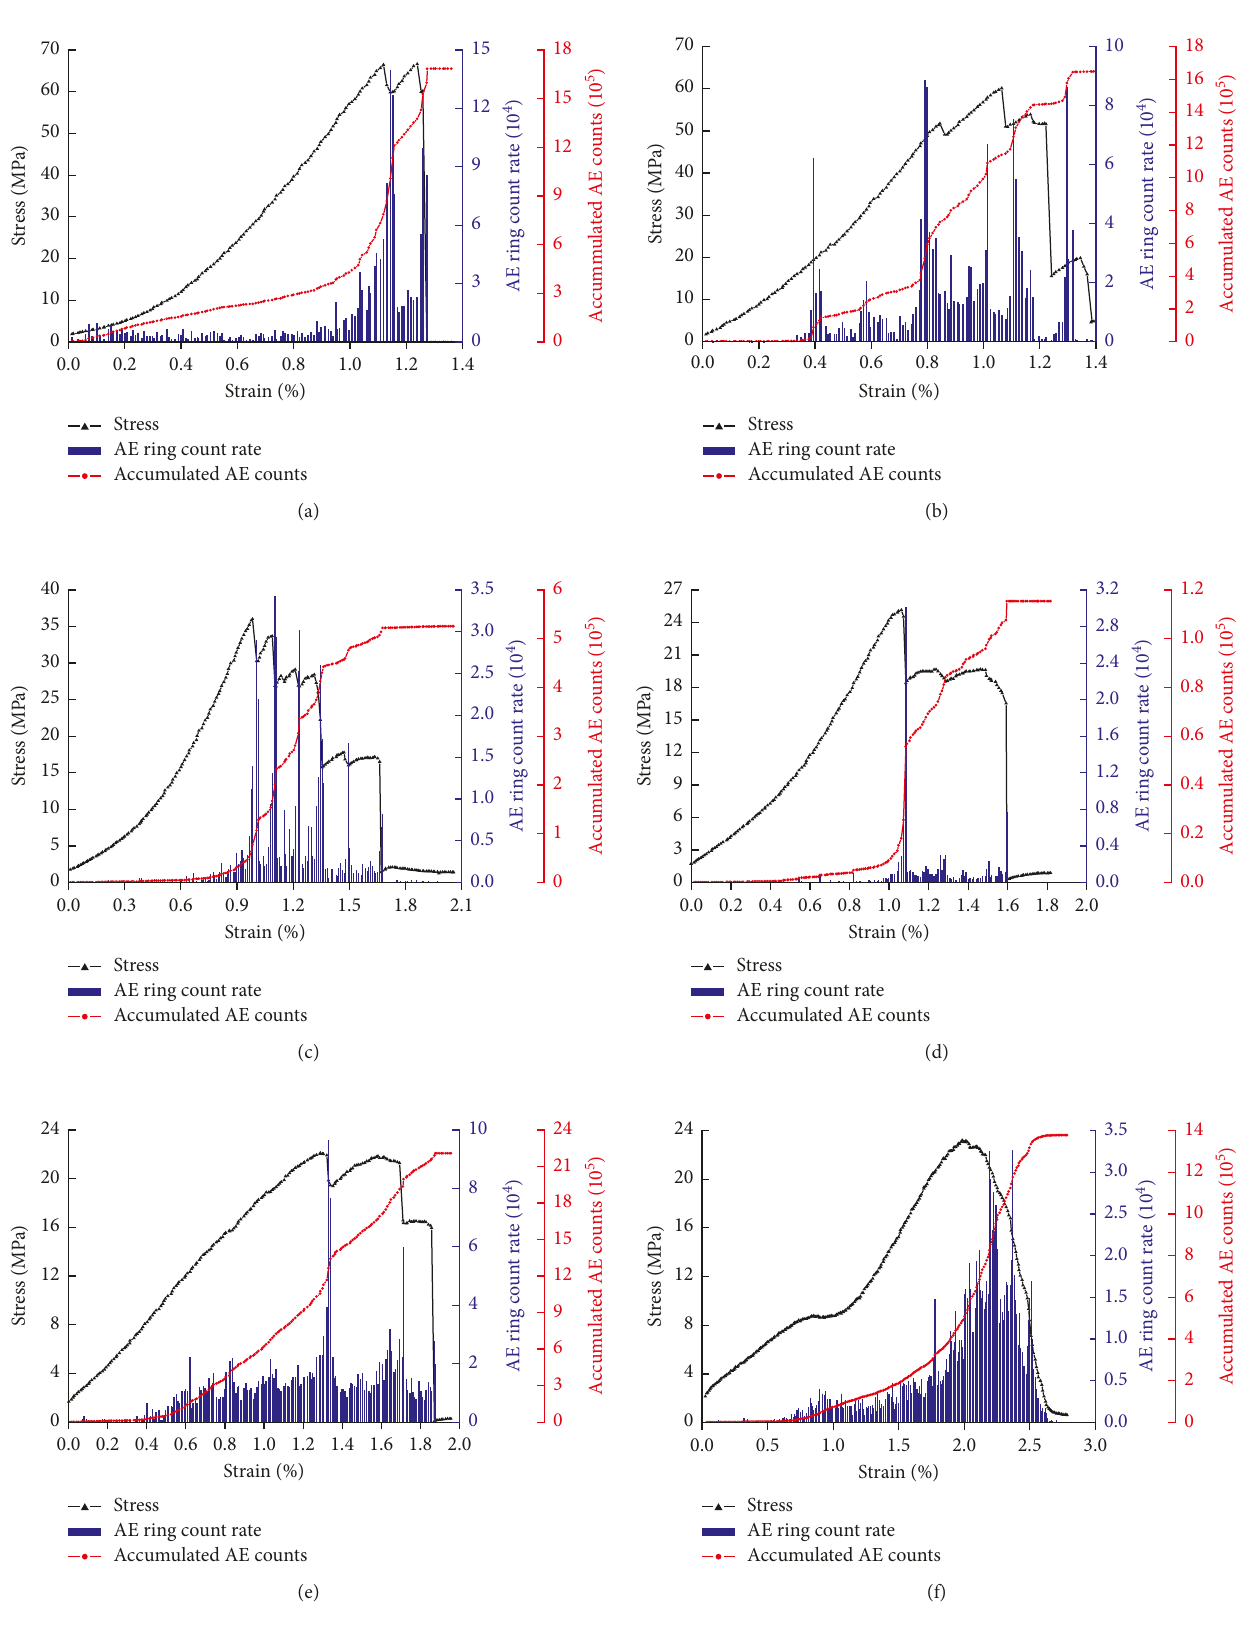
Figure 5: Stress-strain and AE curves of granite under uniaxial compression test at high temperatures. (a) 25 ° C, (b) 200 ° C, (c) 400 ° C, (d) 600 ° C, (e) 800 ° C, and (f) 1000 °